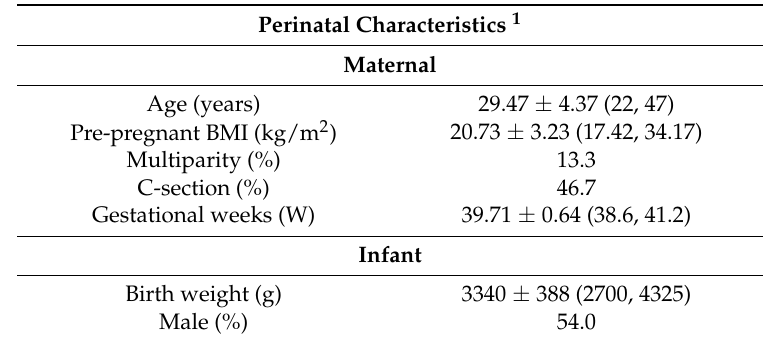
Table 1. Reported subject